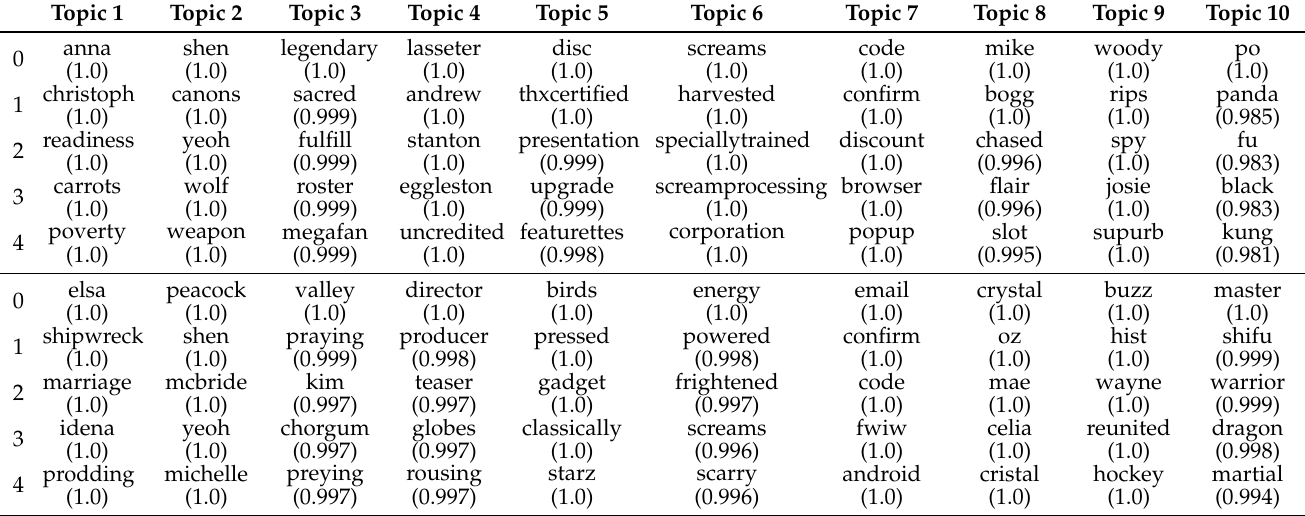
Table A17. For the most significant two words per topic, the four nearest neighbors based on cosine similarity are